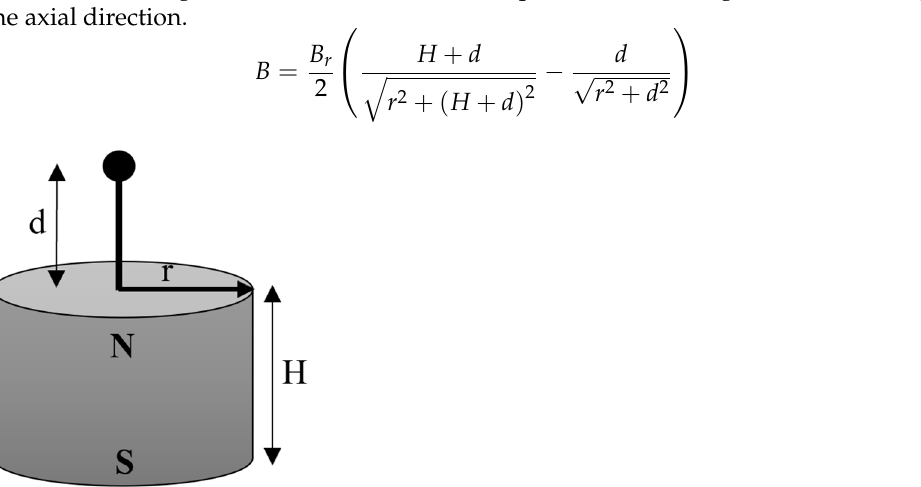
Figure 3. The magnetic flux density of a cylindrical bar magnet (radius r and thickness H) in the axial direction at a distance d.